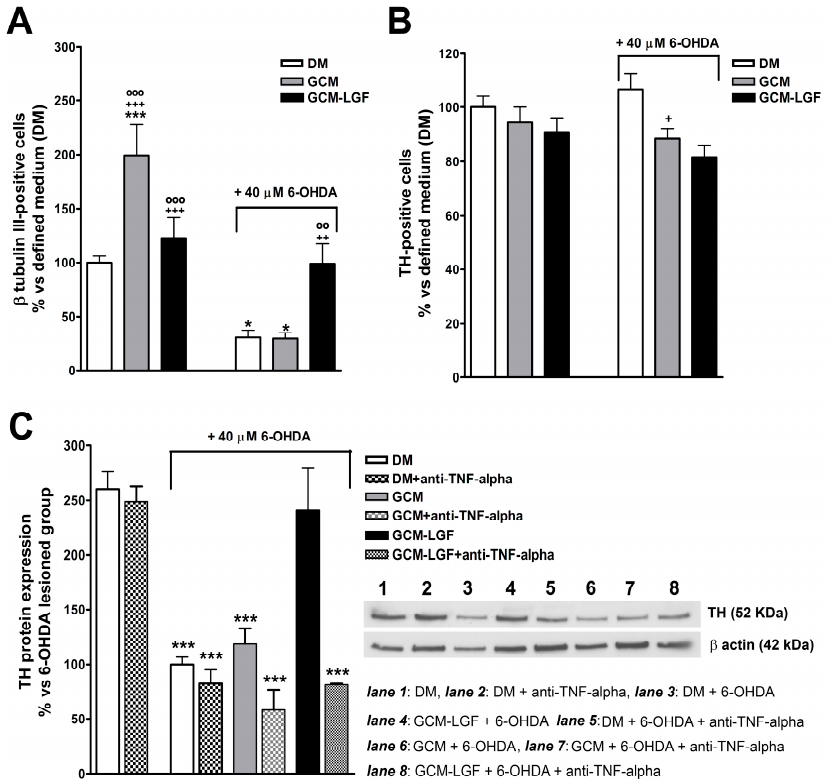
Figure 8. Effects of glial-conditioned medium obtained from LGF-treated mesencephalic glia on dopaminergic neurons. By using immunocytochemistry, we analyzed the effect of GCM (grey bars) and glial-conditioned medium obtained from 100 pg/mL GCM-LGF (black bars) on the population of TH-positive ( A ) and β -tubulin III-positive cells ( B ) in 40 μ M of 6-OHDA-treated mesencephalic neuronal cultures. Note how GCM-LGF prevented the decrease in the percentage of TH-positive cells promoted by the neurotoxin ( A ). The results represent the mean ± SEM of 7–10 coverslips from 3 independent experiments. * p ≤ 0.05, *** p ≤ 0.001 vs DM (white bars), + p ≤ 0.05, ++ p ≤ 0.01, +++ p ≤ 0.001 vs DM and 40 μ M of 6-OHDA., ◦◦◦ p ≤ 0.001 vs GCM and 40 μ M of 6-OHDA. ( C ) shows the Western blot analysis of TH expression in mesencephalic cultures. Note how GCM-LGF preserved TH reduction, as promoted by 40 μ M of 6-OHDA (black bar), as well as how this neuroprotective effect was not observed when cultures were treated with GCM-LGF in the presence of 1 μ g/mL anti- TNF-alpha blocking antibody (last dot bar). In ( C ), lane 1: DM; lane 2: DM and anti-TNF-alpha; lane 3: DM and 6-OHDA; lane 4: DM, 6-OHDA and anti-TNF-alpha; lane 5: GCM and 6-OHDA; lane 6: GCM, 6-OHDA and anti-TNF-alpha; lane 7: GCM-LGF and 6-OHDA; and lane 8: GCM-LGF, 6-OHDA and anti-TNF-alpha. The results represent the mean ± SEM of 3 independent experiments. *** p ≤ 0.001 vs DM (ANOVA and Newman–Keuls).